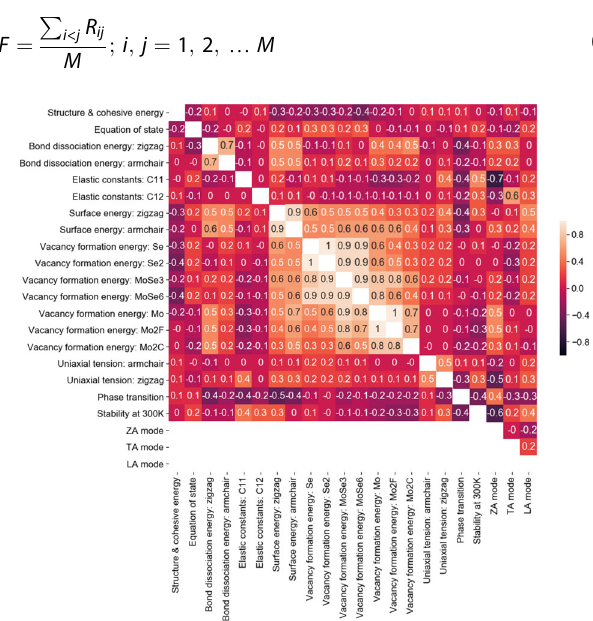
Fig. 4 Correlation matrix of the Tersoff potential. The Pearson correlation coef fi cient for the corresponding pair of properties, ranging from − 1 to 1, is shown in each cell. When calculating the correlation coef fi cients, individuals with percentage errors > 100% for any property were excluded to explore the region in the criterion space, where promising candidates are selected. Two correlation matrices are shown; the bottom corresponds to the as-optimized Tersoff potential and the top corresponds to the same population with additional screening on the three acoustic phonon modes, ZA, LA, and TA. Since each correlation matrix is symmetric, only half of the correlation matrix is shown and the diagonal components (always equal to 1) are removed for clarity. For visualization purposes, all correlation coef fi cients are rounded to a decimal. Thus, a value of “ − 0 ” means the true correlation coef fi cient is within [ − 0.05, 0]. The cells are colored according to their correlation coef fi cients. Uniaxial tension items herein refer to curves under soft mode (see Supplementary Note 1).